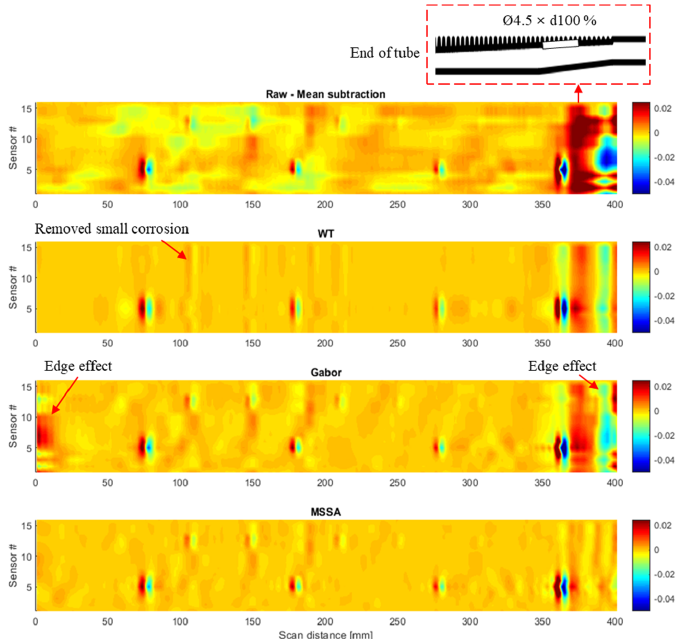
Figure 12. Magnetic scanned signal by the PSECT method with the end of the tube